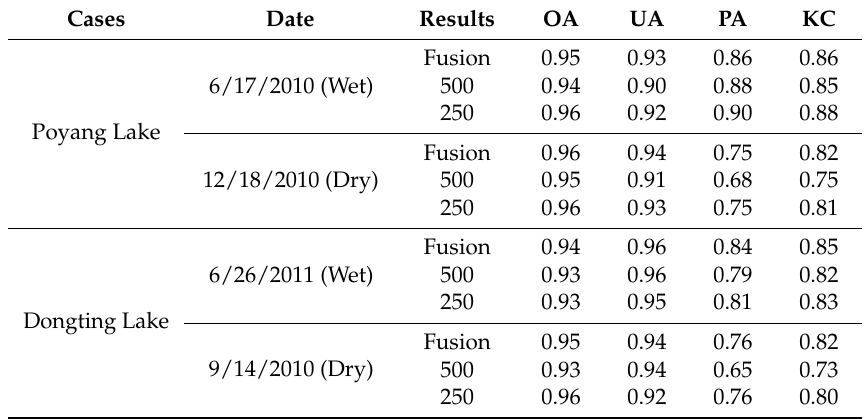
Figure 7. Water extraction results of the wet and dry season in Dongting Lake and Poyang Lake. ( a , b ) are Dongting Lake for 17 June 2010 and 18 December 2010; ( c , d ) are Poyang Lake for 26 June 2011 and 14 September 2010. A false color with bands 5, 4 and 3 is used to represent the characteristics of the images, and dark red masks are the generated water extraction. Table 1. The water extraction accuracy of Dongting Lake and Poyang Lake in the wet and dry season. Cases Date